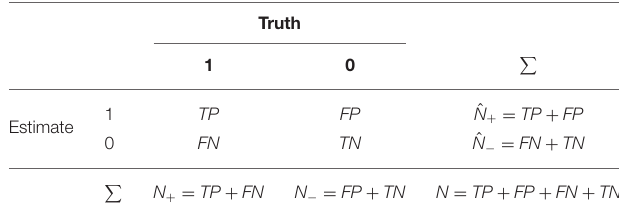
TABLE 1 | An example of a confusion matrix. N ˆ N + is the number of estimated positives, N − is the number of true negatives, and ˆ N − is the number of estimated